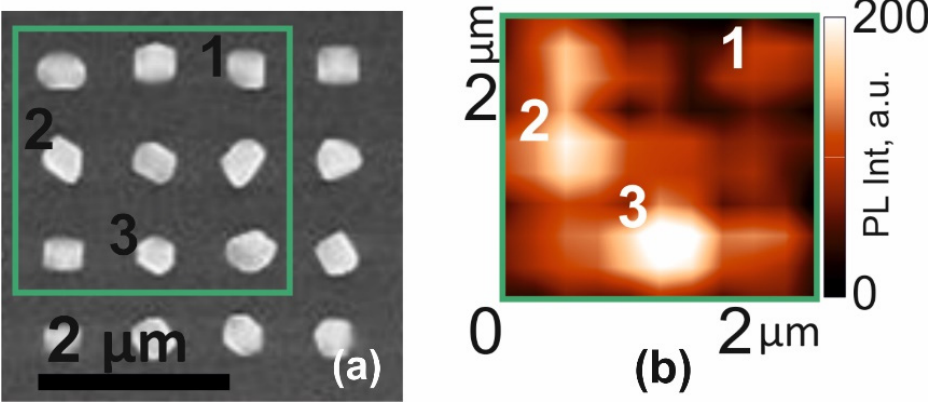
Figure 6. ( a )—SEM image obtained from above sample S3; ( b )—map of the photoluminescence intensity distribution in the spectral range from 1150 to 1400 nm in the sample area highlighted by the rectangle in ( a ).